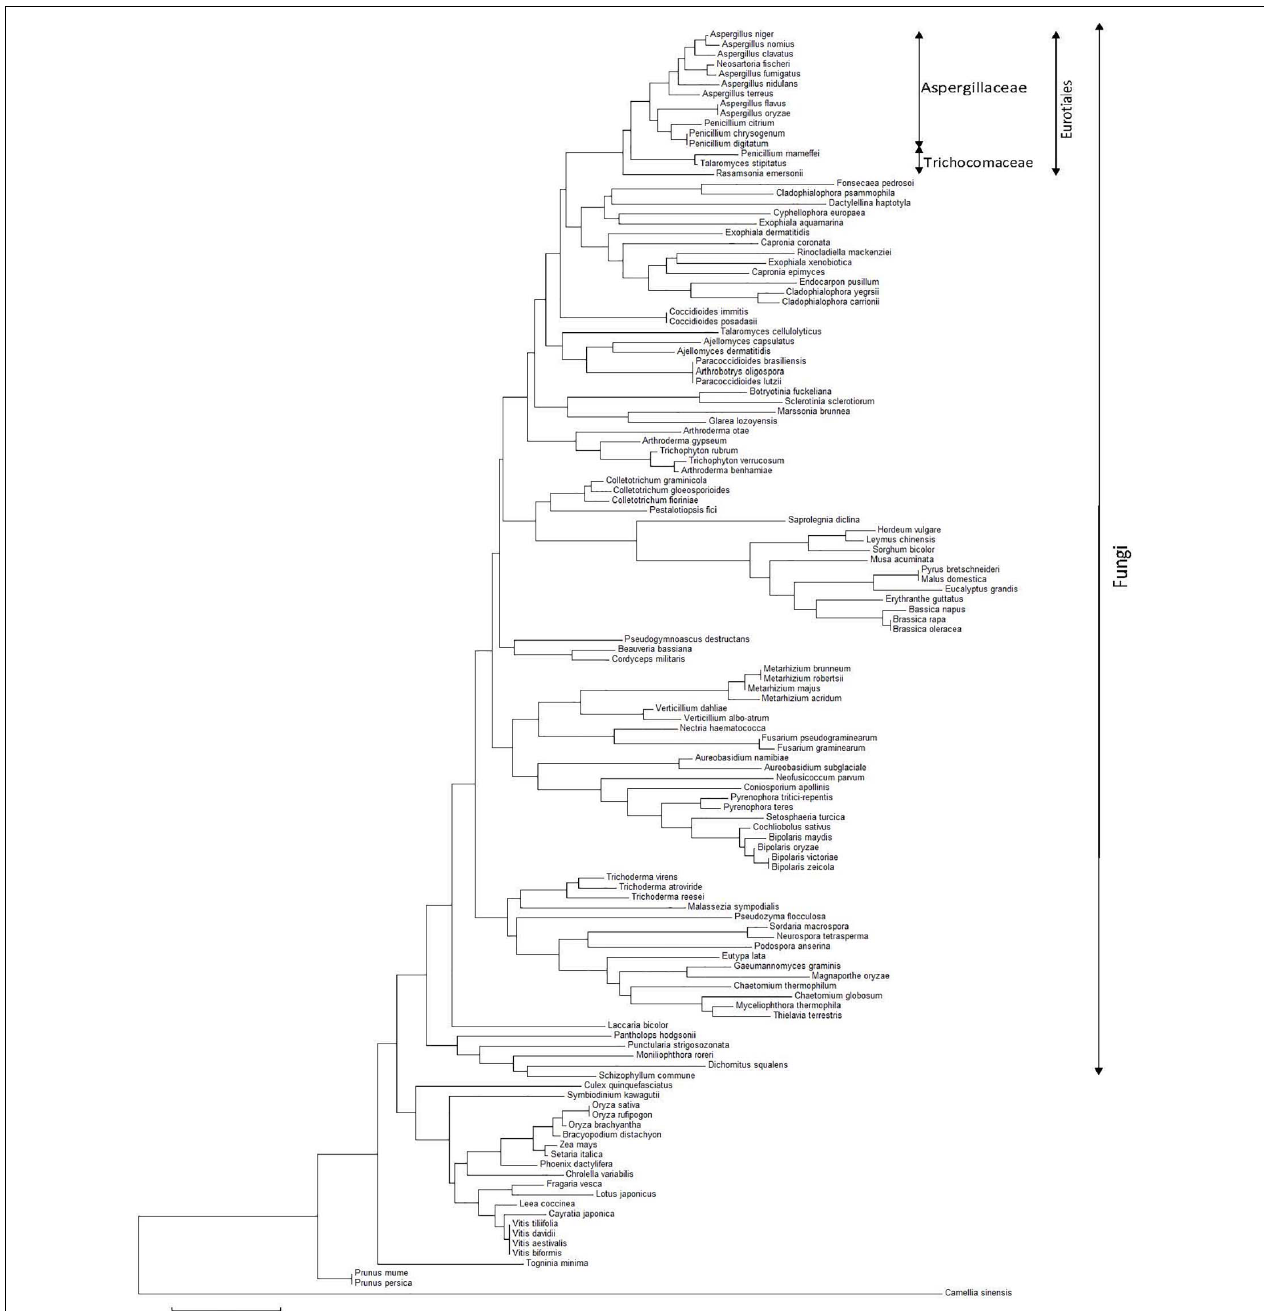
FIGURE 5 | Phylogenetic tree of the nearest neighborhood of representatives constructed on the basis of the nucleotide sequences of Asp n 3 homologs (peroxyredoxin proteins) encoding genes belonging to species from different kingdoms, with special accent on the fungi kingdom.